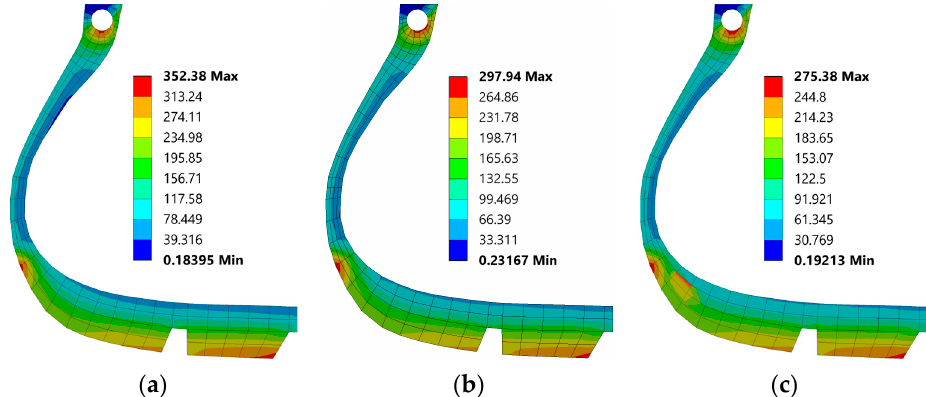
Figure 15. Distribution of heat flux in rubber with different pressures and the loading of 6 kN (unit: W/m 3 ): ( a ) 28 psi; ( b ) 32 psi; ( c ) 34 psi.